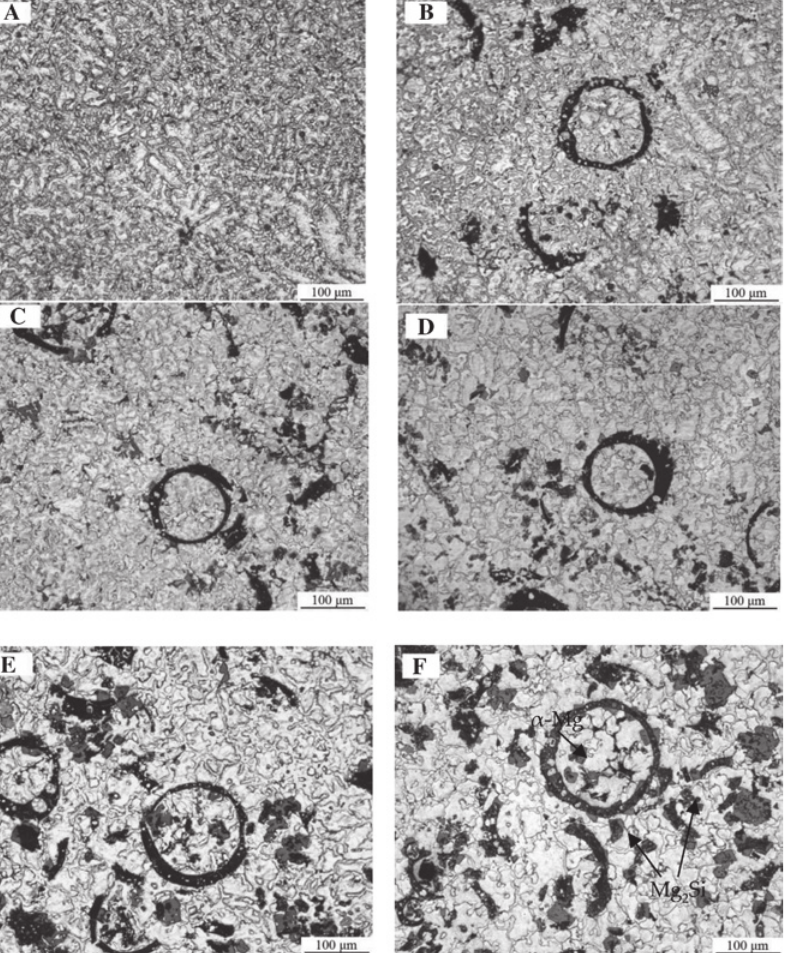
Figure 3: Microstructures of the base Mg alloy (A, alloy 1) and FAC/Mg alloy degradable composites (B, alloy 2; C, alloy 3; D, alloy 4; E, alloy 5; F, alloy 6).